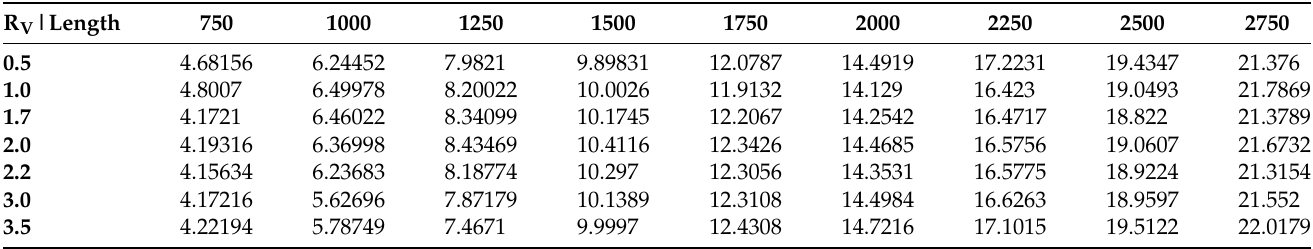
Table A11. Execution times in milliseconds on CPU with ring structure for 40,000 time-steps (2.0 s); R V on the Left and number of cells (length) on the Top .